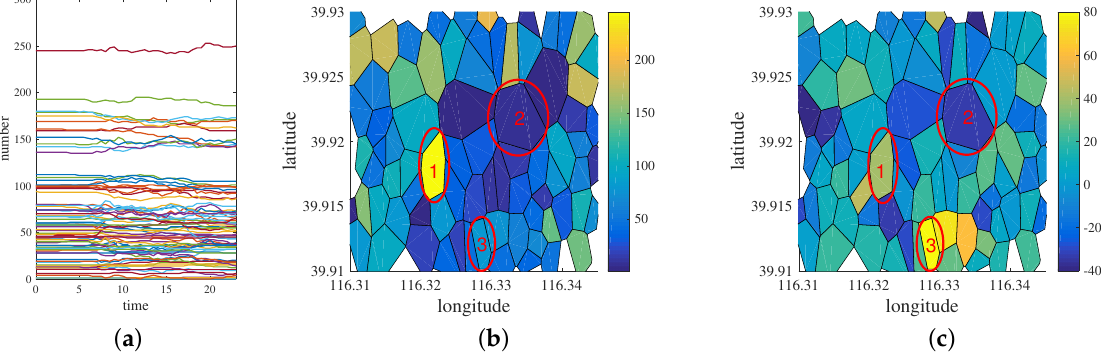
Figure 9. The results of case analysis. ( a ) The change of the predicted number of dockless shared bikes in each aggregation area over time. Different color lines represent different aggregation areas. ( b ) The number of dockless shared bikes in each aggregation area at 00:00 on 6 December 2017 in geographical space. The value corresponding to the color is shown in the color bar. ( c ) The change of the number of dockless shared bikes in each aggregation area within one